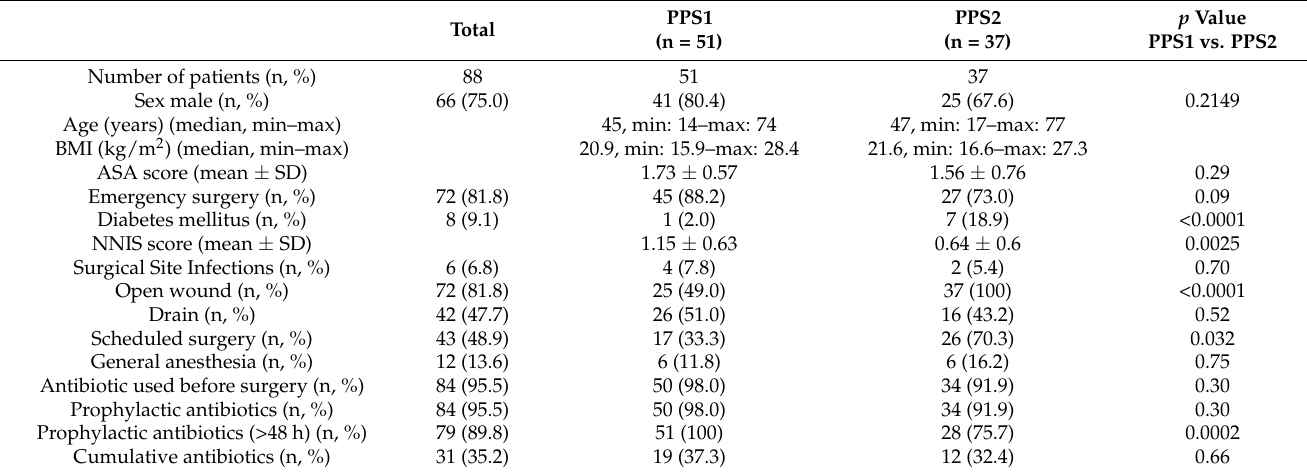
Table 1. Characteristics of study population using the Point Prevalence Survey (PPS) performed in 2016 (PPS1) and in 2019